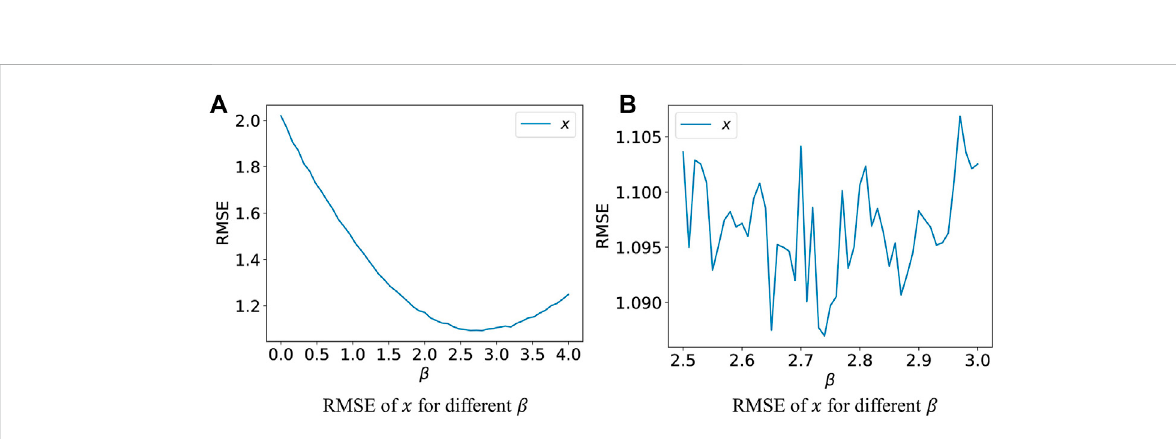
FIGURE 6 Fix σ , ρ and vary β to estimate x , y , z . (A,B) plot the RMSE of the state x with different